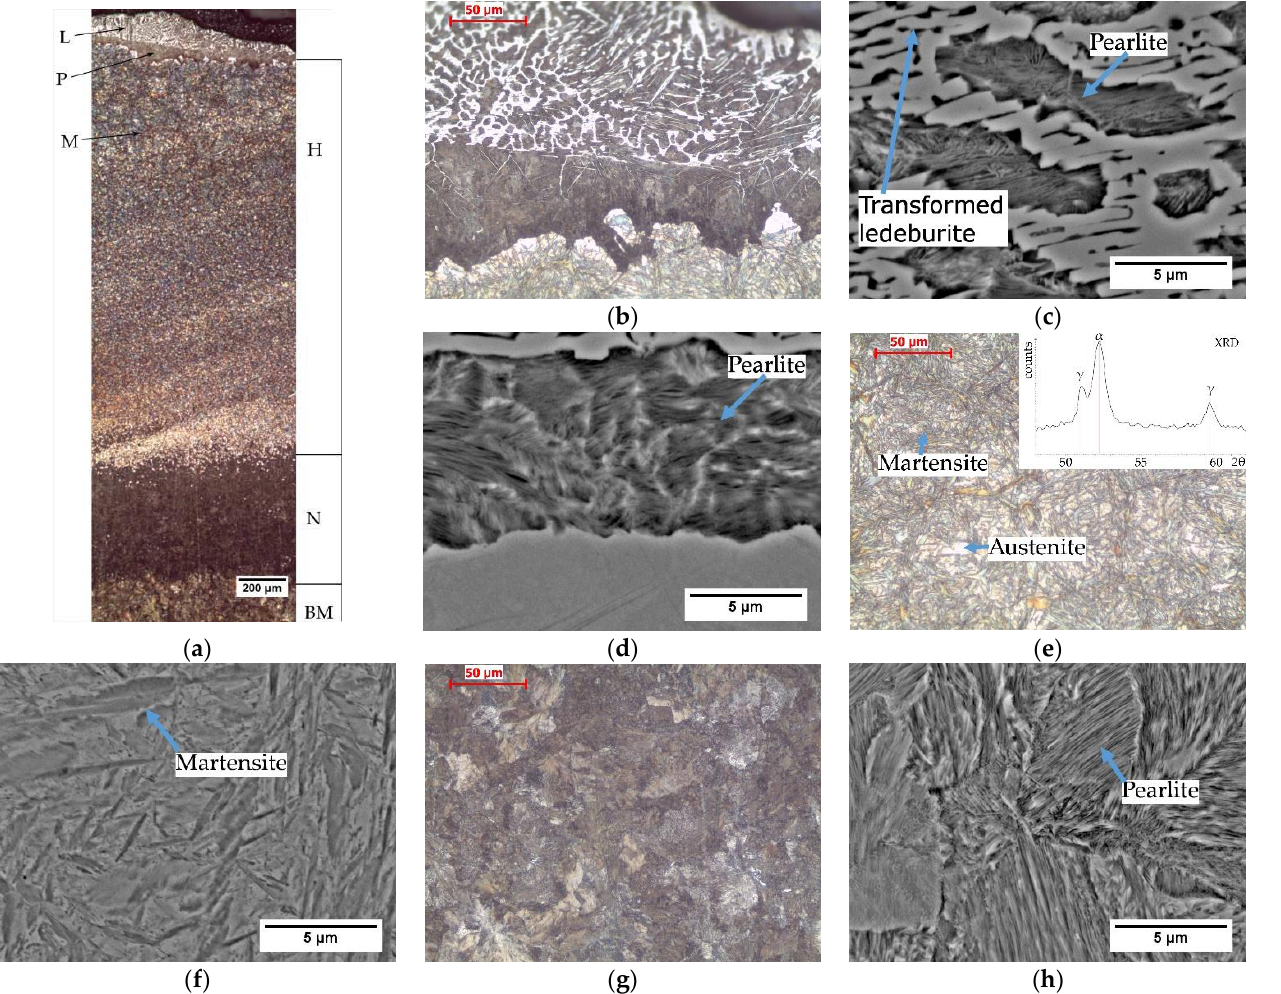
Figure 2. Microstructure at the cut surface: ( a ) general view (H—hardened zone, N—normalization zone, BM—base material, L— transformed ledeburite + pearlite + secondary cementite, P—pearlite with secondary cementite, M—martensite with austenite); ( b ) detail view near cut surface; ( c ) transformed ledeburite (486 HV0.01), pearlite (222 HV0.01) and secondary cementite (605 HV0.01); ( d ) pearlite with secondary cementite (375 HV0.01), ( e,f ) martensite with austenite (820 HV0.01) and XRD pattern in top right inset; ( g – h ) pearlitic microstructure of the material heated in the cutting process to a temperature lower than A c1 —base material (227 HV0.01).